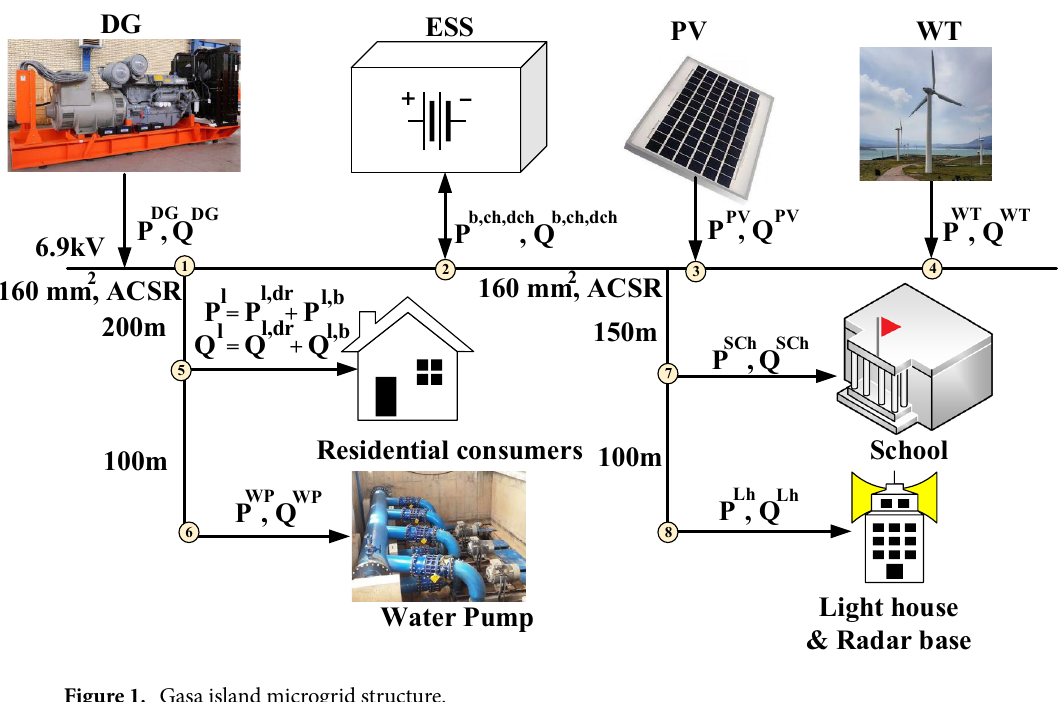
Figure 1. Gasa island microgrid